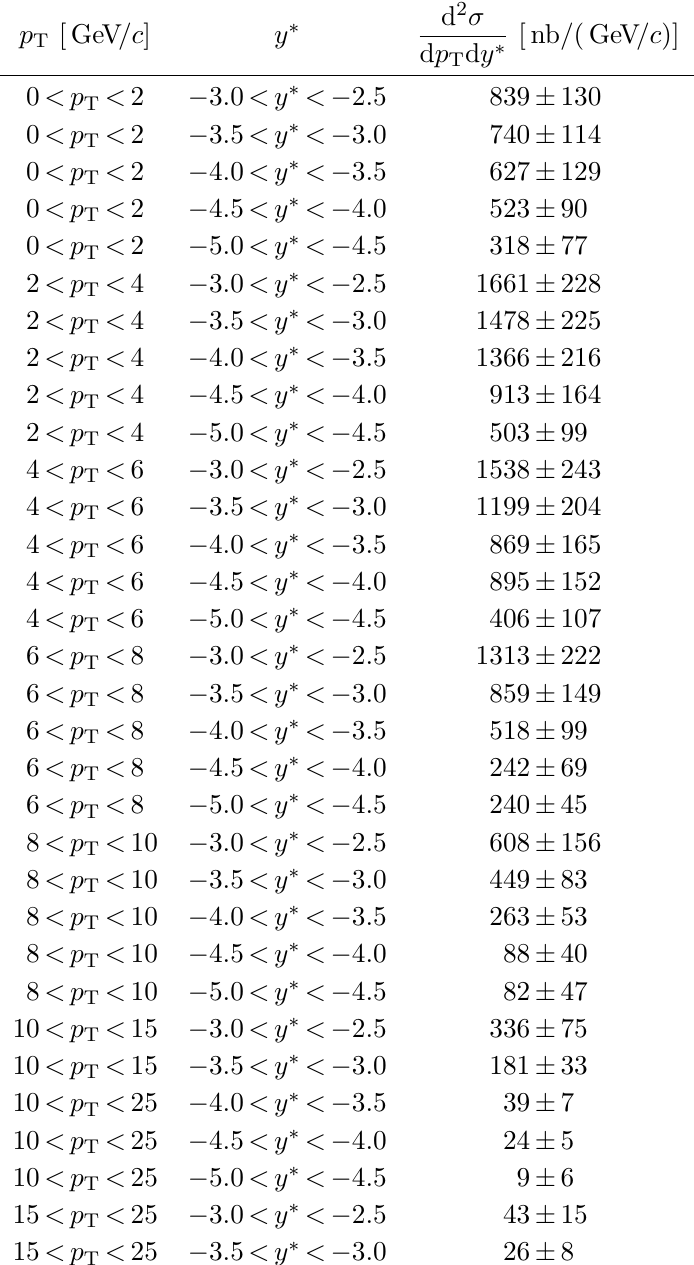
Table 5 . (cid:7) (1 S ) production cross-section in Pb p , as a function of p T and y (cid:3)